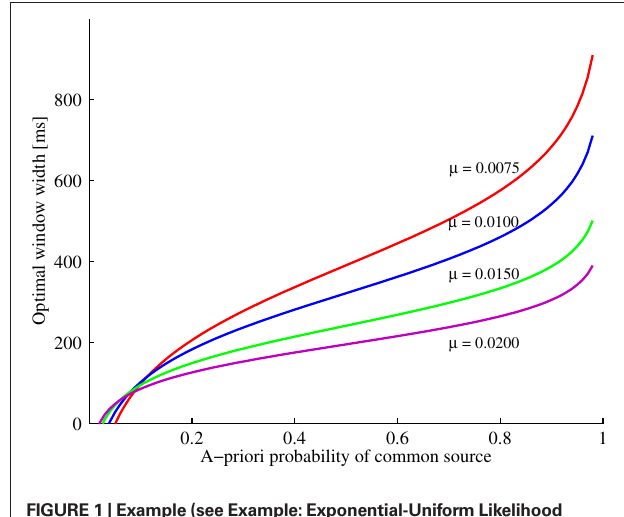
FIgure  | example (see example: exponential-uniform Likelihood Functions) with exponential-uniform likelihood functions: Optimal window width increases as a function of the a priori probability of a common event. The increase becomes less steep by increasing the likelihood of an arrival time difference of zero